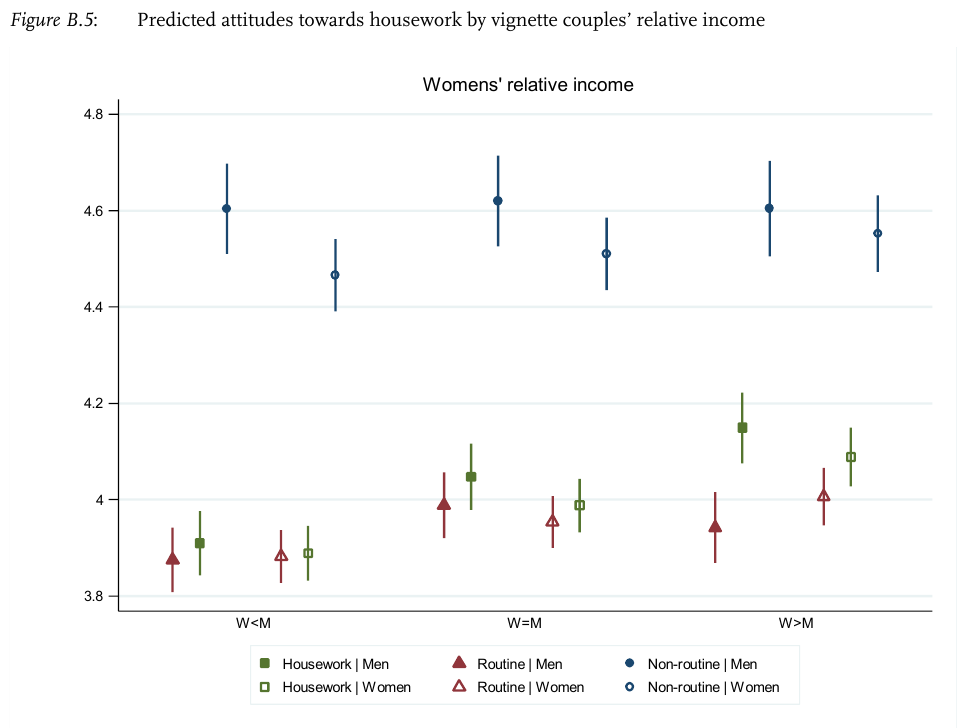
Figure B.5 : Predicted attitudes towards housework by vignette couples’ relative